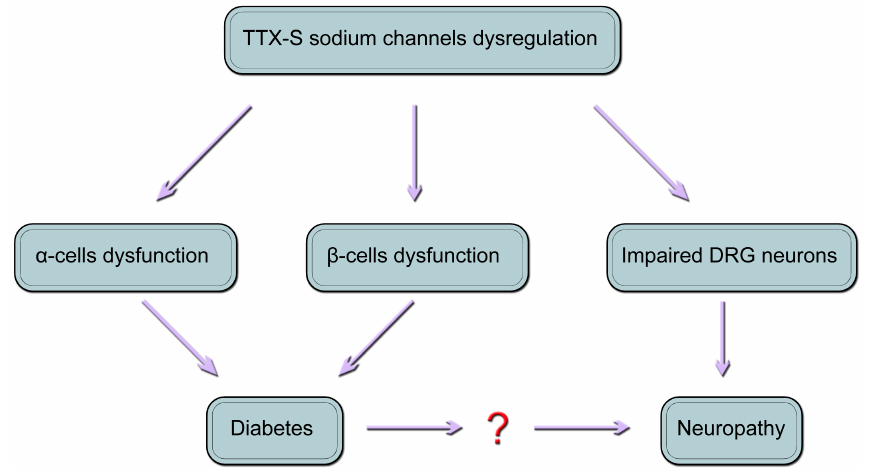
Figure 1. A model of the relationship between diabetes and neuropathy. The dysregulation of tetrodotoxin-sensitive (TTX-S) sodium channels, which are expressed in pancreatic α cells, β cells and dorsal root ganglion (DRG) neurons, leads to diabetes and periphery neuropathy. This model is modified from Hoeijmakers et al. [42].